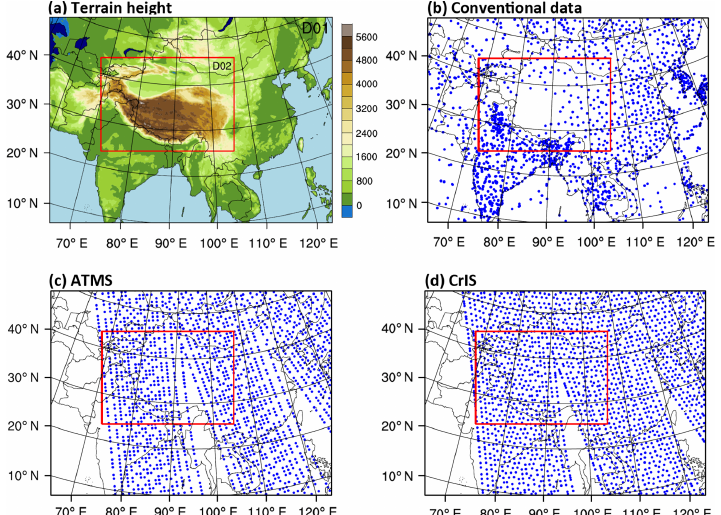
Figure 1. (a) Simulation domains and topography. Resolutions are at 12 and 4km for the outer (coarse grid, D01) and inner (nested grid, D02) boxes, respectively. The shading indicates the terrain elevation (unit: m). (b–d) Distribution of (b) conventional data observations, (c) scan coverage of ATMS data after data assimilation, and (d) scan coverage of CrIS data after data assimilation at 06:00UTC on 1 July 2015.